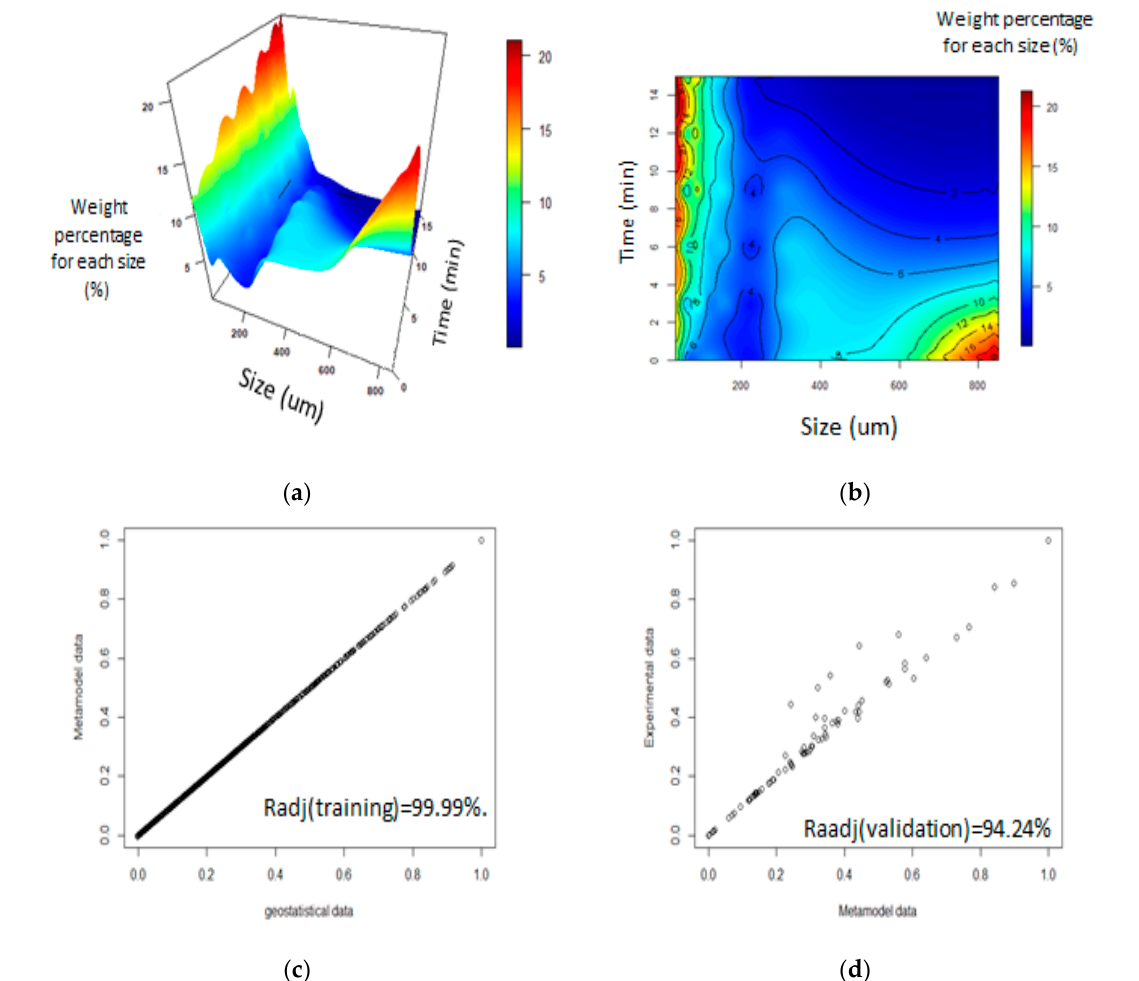
Figure 12. Results obtained for LGP-1 for ore-B. ( a ) Spatial trend with normalized data. ( b ) Contours graphic. ( c ) Cross-analysis with the meta-model data and geostatistical data. ( d ) Cross-analysis with experimental data and meta-model data.